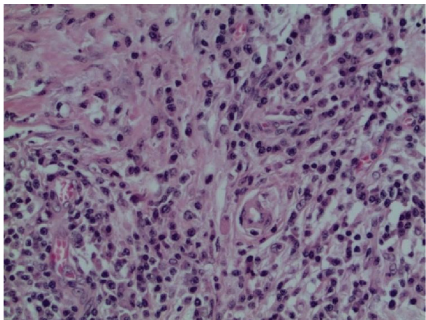
Figure 2: The submandibular gland shows extensive lympho- plasmacytic infiltrate intermixed with prominent fibrosis.